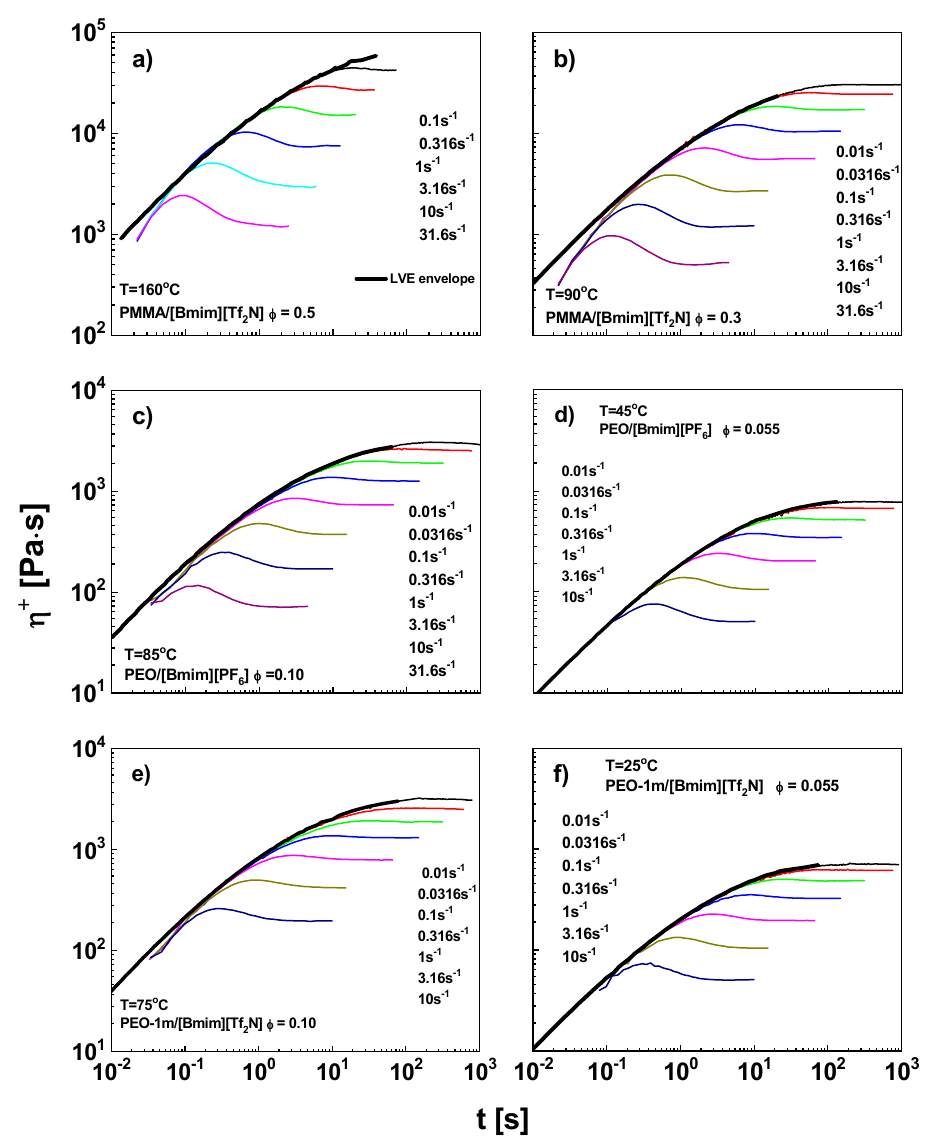
Figure 3. Nonlinear startup shear viscosity η + (thin curves) as a function of time for PMMA / [Bmim][Tf 2 N] with φ = ( a ) 0.50 and ( b ) 0.30, for PEO / [Bmim][PF 6 ] with φ = ( c ) 0.10 and ( d ) 0.055, and for PEO / [Bmim][Tf 2 N] with φ = ( e ) 0.10 and ( f ) 0.055. In each panel, the shear rates increase from top to bottom with a logarithmic interval of 0.5. The thick curves are LVE envelopes.